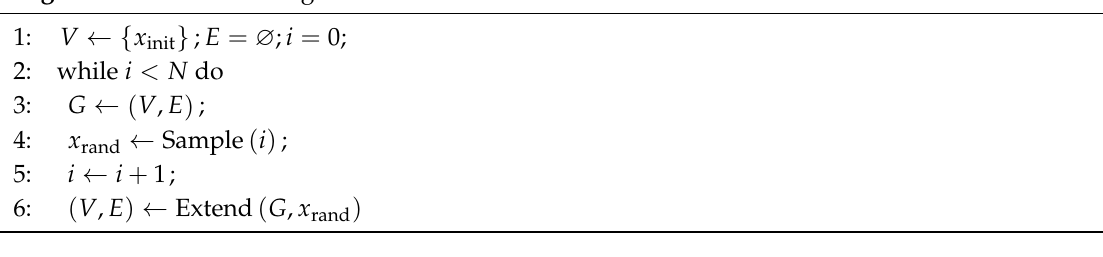
Algorithm 3: Extend function of the RRT algorithm